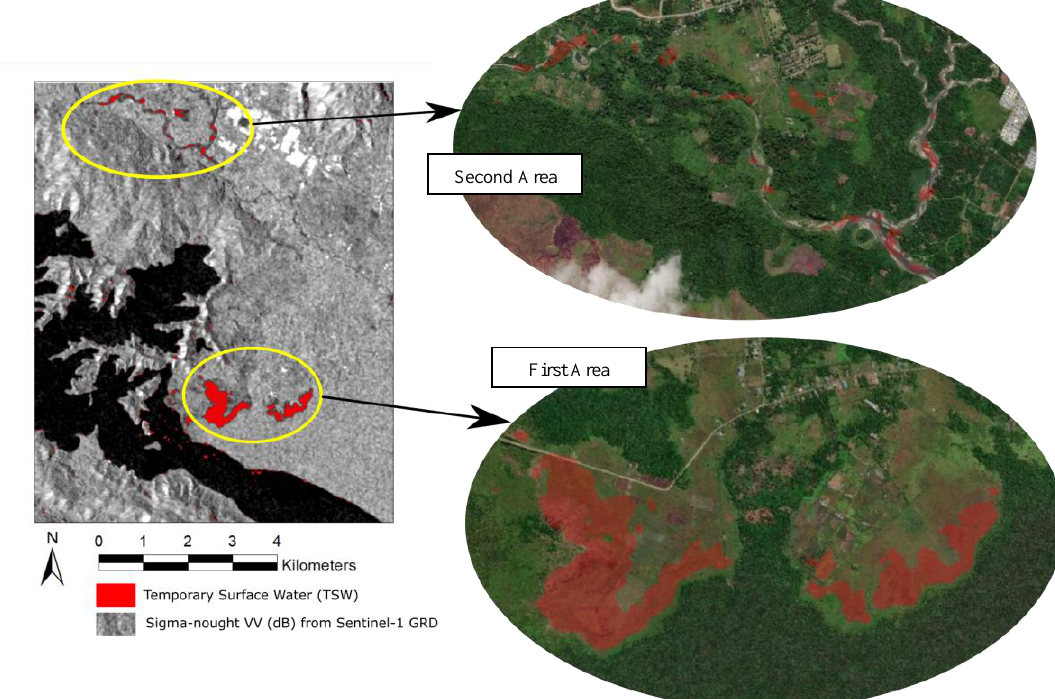
Figure 4. Observation in Temporary Surface Water (TSW) results from rapid mapping of Sentinel-1